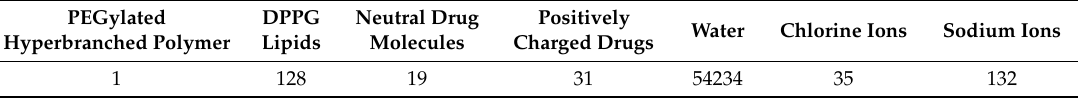
Table 1. Number of molecules/ions of each type included in the simulated